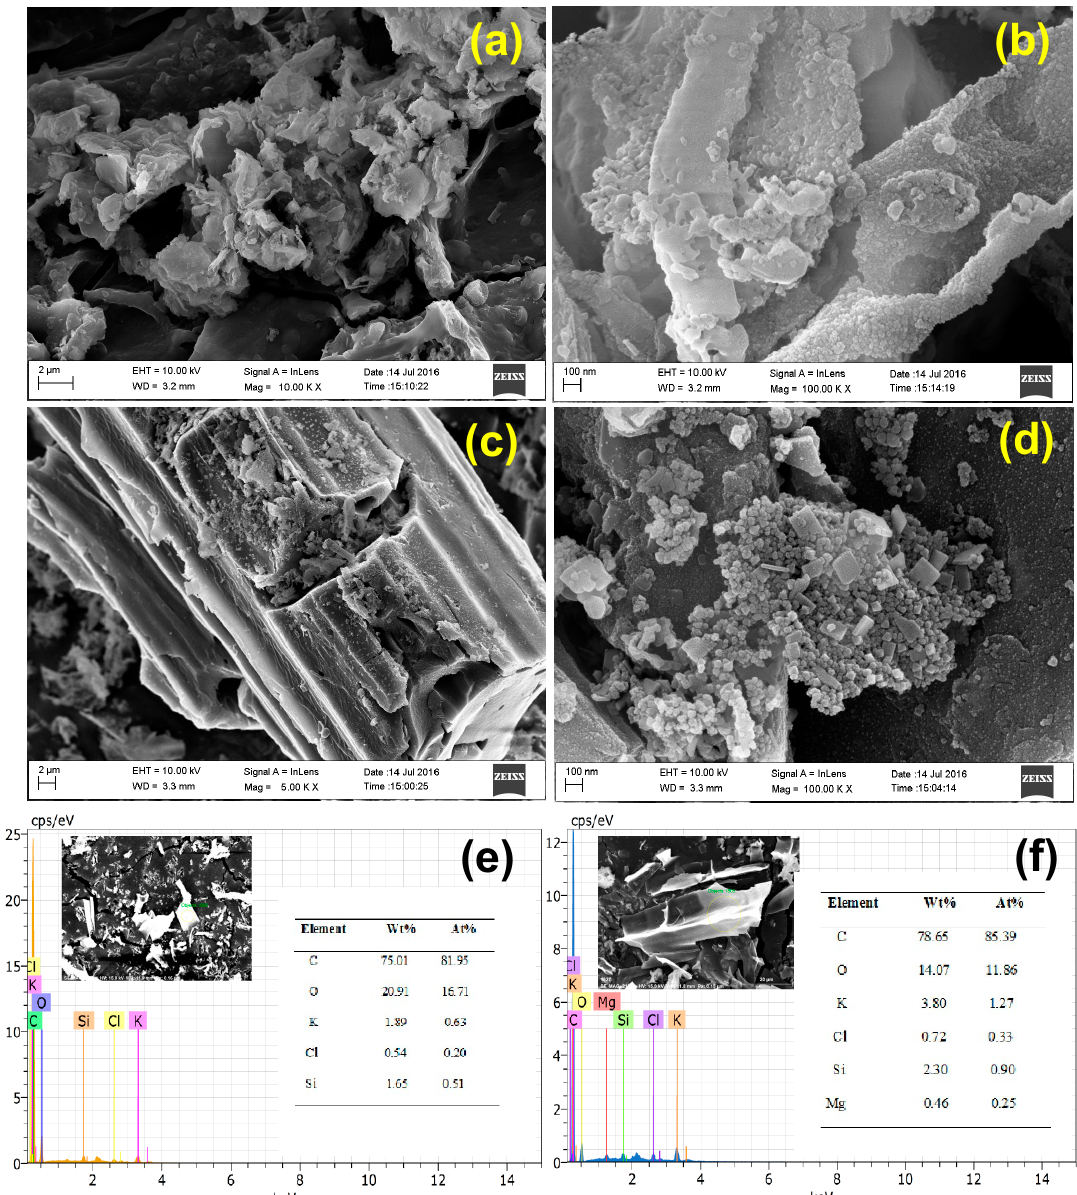
Figure 1. FESEM images of ( a ) sugarcane bagasse ash (SBA) annealed at 500 ◦ C ( b ) SBA annealed at 750 ◦ C ( c ) magnified FESEM image of SBA at 500 ◦ C ( d ) magnified FESEM image of SBA at 750 ◦ C ( e ) EDS spectrum of SBA annealed at 500 ◦ C ( f ) EDS spectrum of SBA annealed at 750 ◦ C. The inset